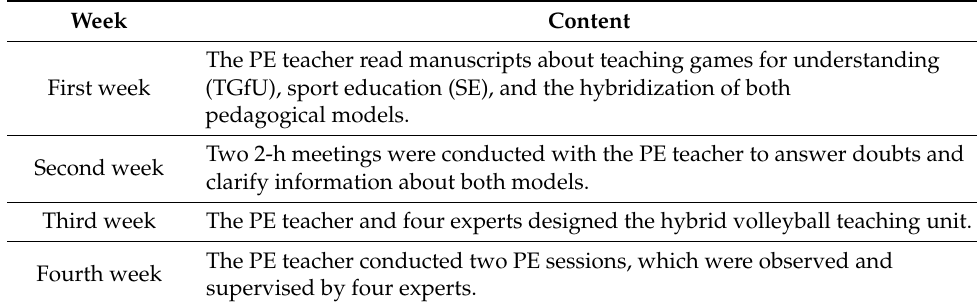
Table 2. Training program for the physical education (PE)